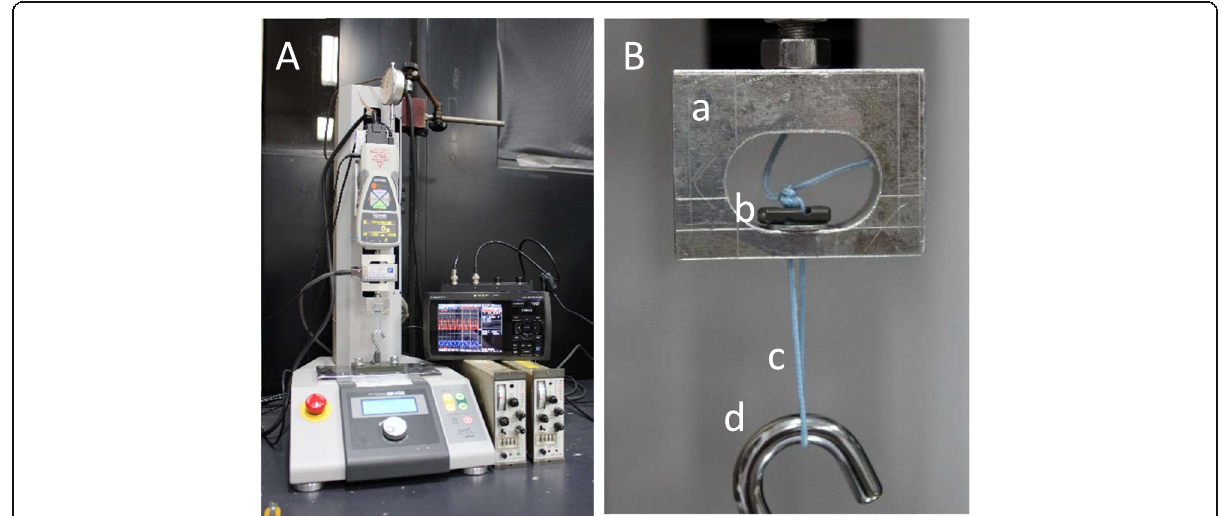
Fig. 2 Test equipment. A Overall view (B) Testing part. a. Tension jig that simulate bone hole, b. EndoButton, c. FiberWire (5 M) d.